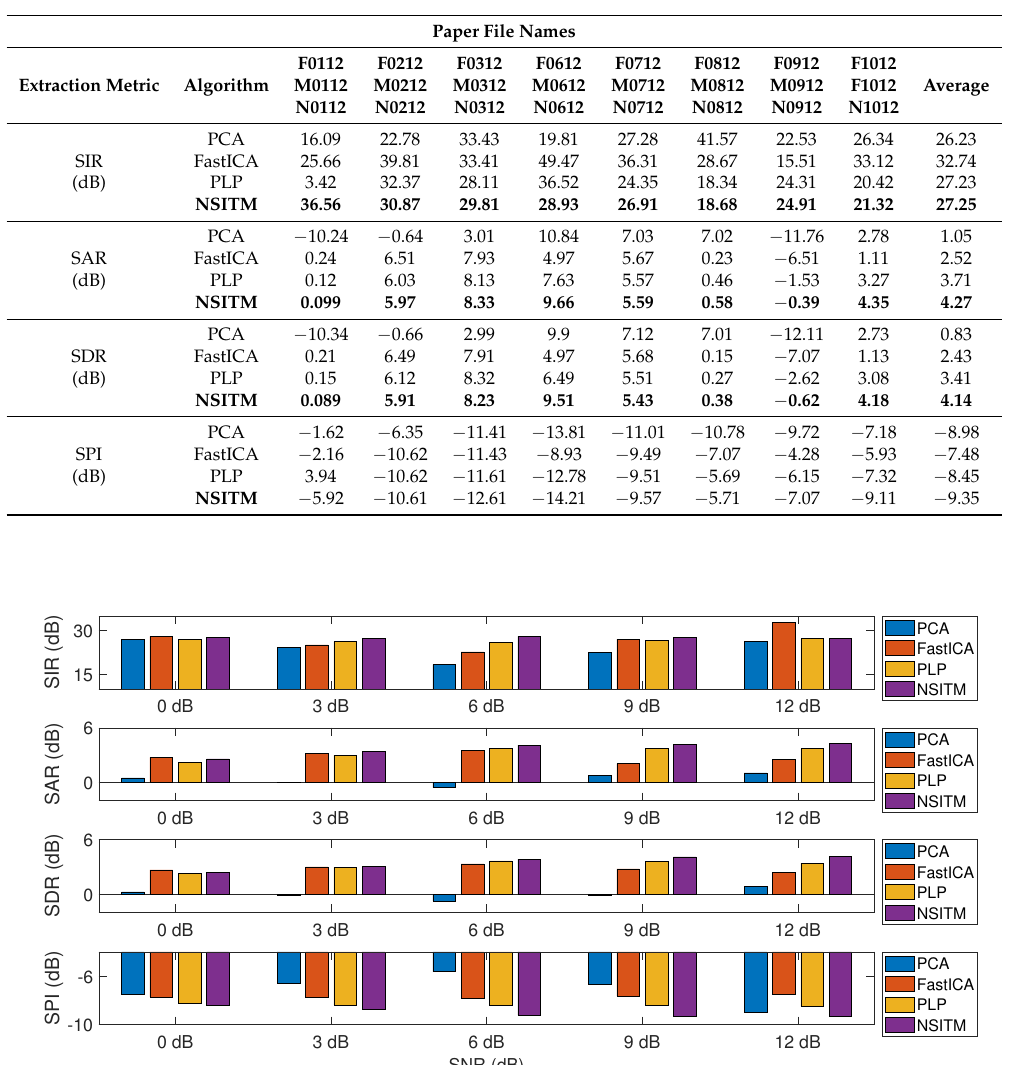
Table 4. Comparison between the FECG extraction performances (SPI, SIR, SAR, and SDR), using the proposed NSITM, PCA, and FastICA algorithms, considering SNR = 12 dB. Data are collected from Physionet/Fetal ECG Synthetic database (FECGSYNDB).